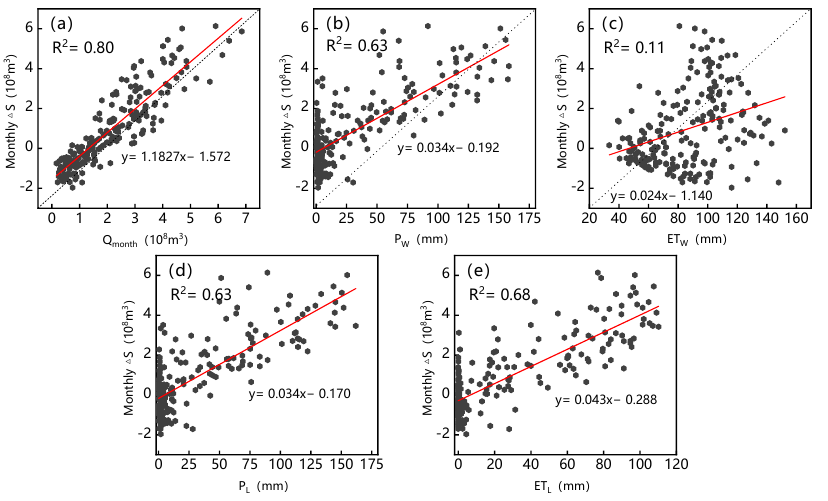
Figure 8. Correlation between lake storage and ( a ) total lake inflow, ( b ) water area precipitation, ( c ) water area evaporation, ( d ) land surface precipitation, ( e ) land surface evaporation. Based on the SPHY model of the Siling Co basin, the runoff into the lake was divided into the four components of GR, SR, RR, and BF. Figure 9 shows the interannual variation in each runoff component of total inflow during the simulation period. Figure 10 repre- sents the seasonal distribution of each runoff component . In general, the total runoff in Siling Co declined significantly between 2000 and 2016 with rates of decrease of 41 million m 3 /yr, and the variation trend of SR, RR, and BF is consistent with the total runoff. However, GR increased significantly at a rate of 11 million m 3 /yr (Figure 9). 2008 is the abrupt point of precipitation change trend through the anal- ysis of regional precipitation characteristics. Compared with the total runoff data from 2000 to 2008, the average runoff from 2009 to 2016 declined by 471 million m 3 . The per- centage contributions of BF and RR were significantly reduced, suggesting that reduced precipitation has a significant impact on BF and RR. Snowfall dropped along with precip- itation, and the SR decreased by 187 million m 3 /yr before and after the precipitation abrupt change. By contrast, the contribution of glacial runoff to total runoff increased by 8.4%, which indicates that the recharge and regulation of runoff to the lake by glacial melting was more significant in the later years of the study period when precipitation was low. However, since the glacial resources are limited and can be greatly impacted by global warming, this water source regulation effect could be weakened [45].